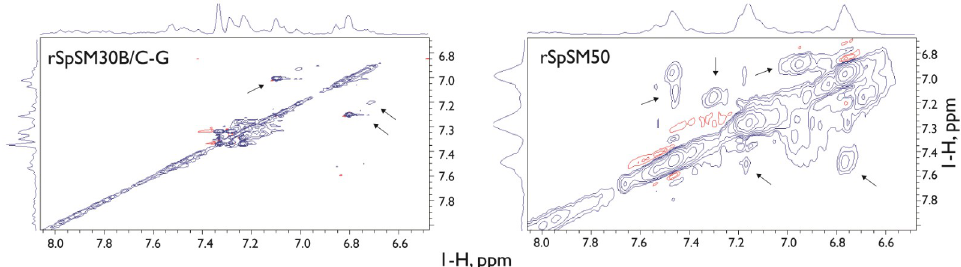
Fig 2. Homonuclear 800 MHz 1 H TOCSY spectra (exchangeable sidechain amide chemical shift region) of 22 μ M rSpSM30B/C-G and rSpSM50 hydrogel particle samples, 100 μ M HEPES, pH 7.5. Diagonal and off-diagonal regions for sidechain and backbone NH Arg, Asn, and Gln resonances are shown, along with corresponding 1-D